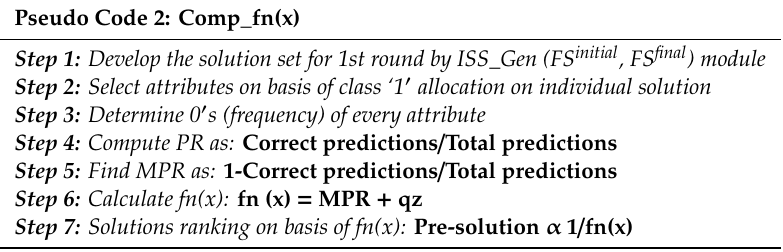
Table 5. Pseudo code 2 for Comp_fn(x). [47].